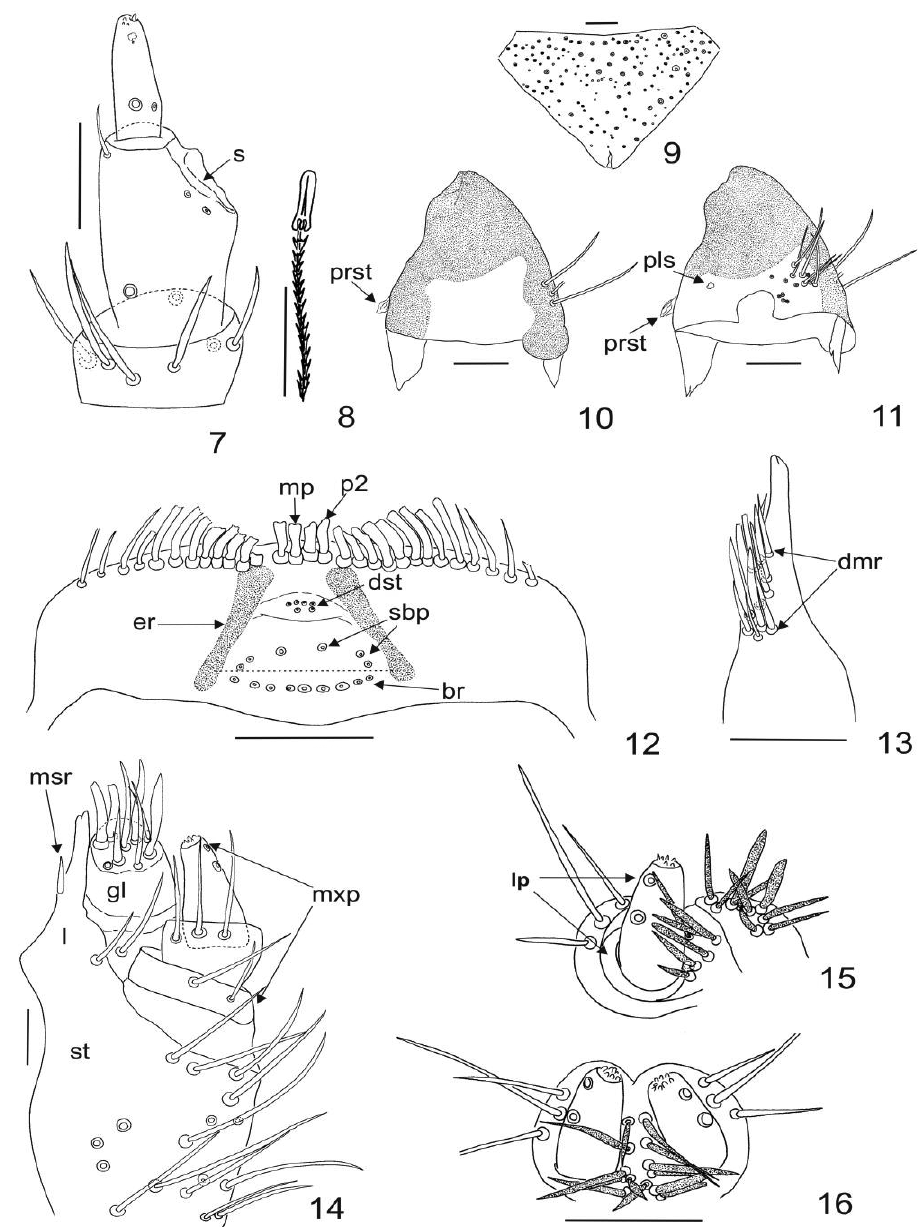
Figures 7–16. Mature larva of Megatoma (s. str . ) undata (Linnaeus, 1758). 7 Antenna (dorso-fronto- lateral) 8 Head (apex) of hastiseta 9 Frons (dorsal) 10 Mandibula (dorsolateral) 11 Mandibula (dorsal) 12 Epipharynx (ventral) 13 Lacinia 14 Maxilla 15 Labium with labial palp (frontolateral) 16 Labium with labial palpi (frontal). Scale bar 0.1